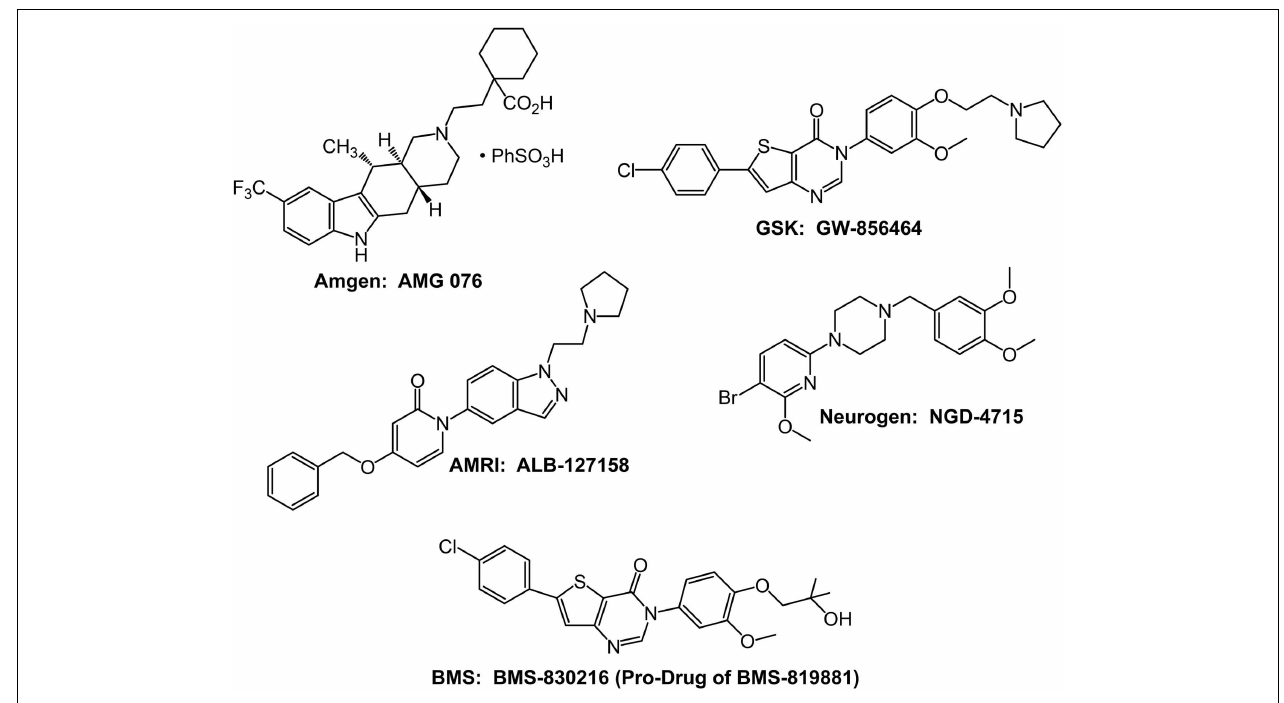
FIGURE 2 | Structures of the five MCHR1 antagonists that have been evaluated in Phase I safety and tolerability